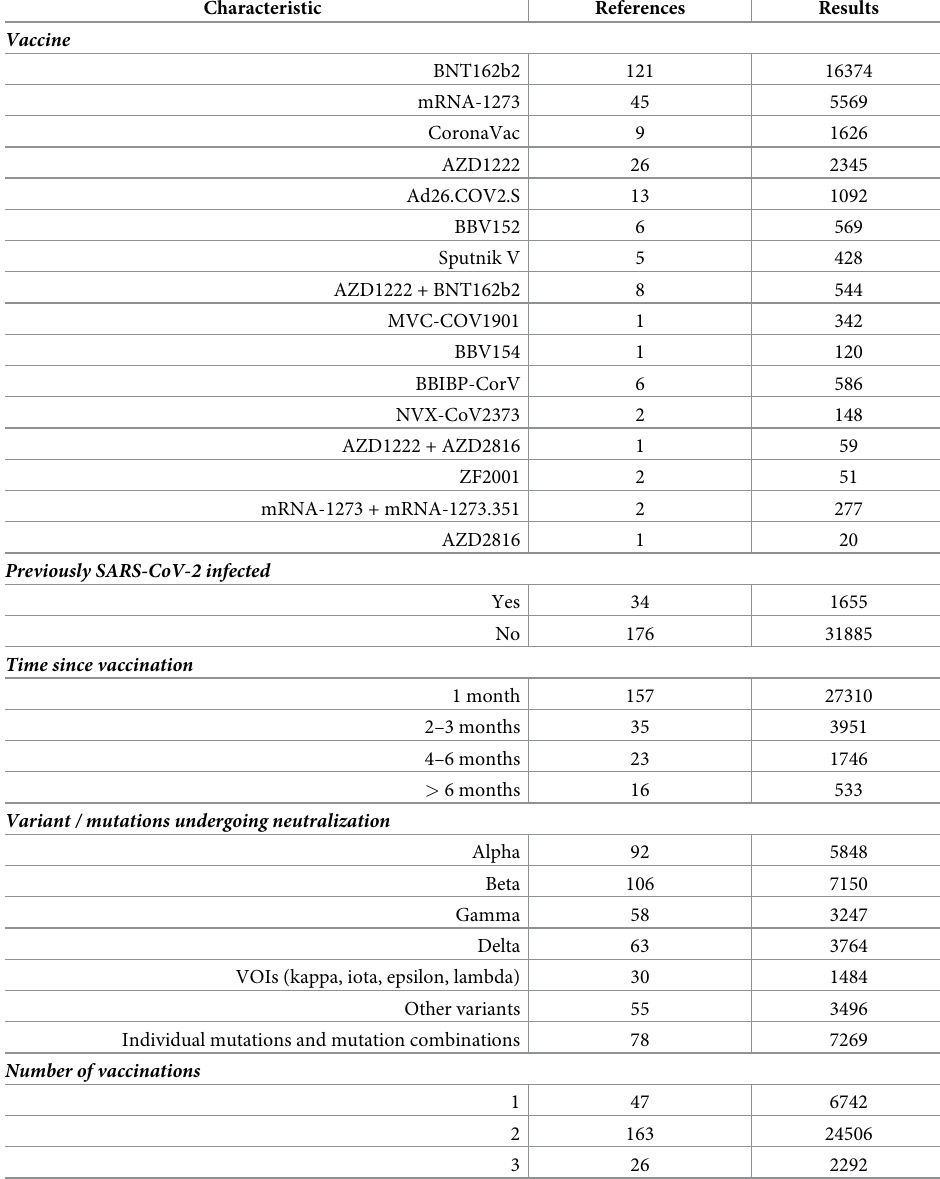
Table 6. Numbers of Vaccinee Plasma (VP) neutralization experiments in CoV-RDB according to the vaccine, history of previous infection, time since infection, and SARS-CoV-2 variant tested.